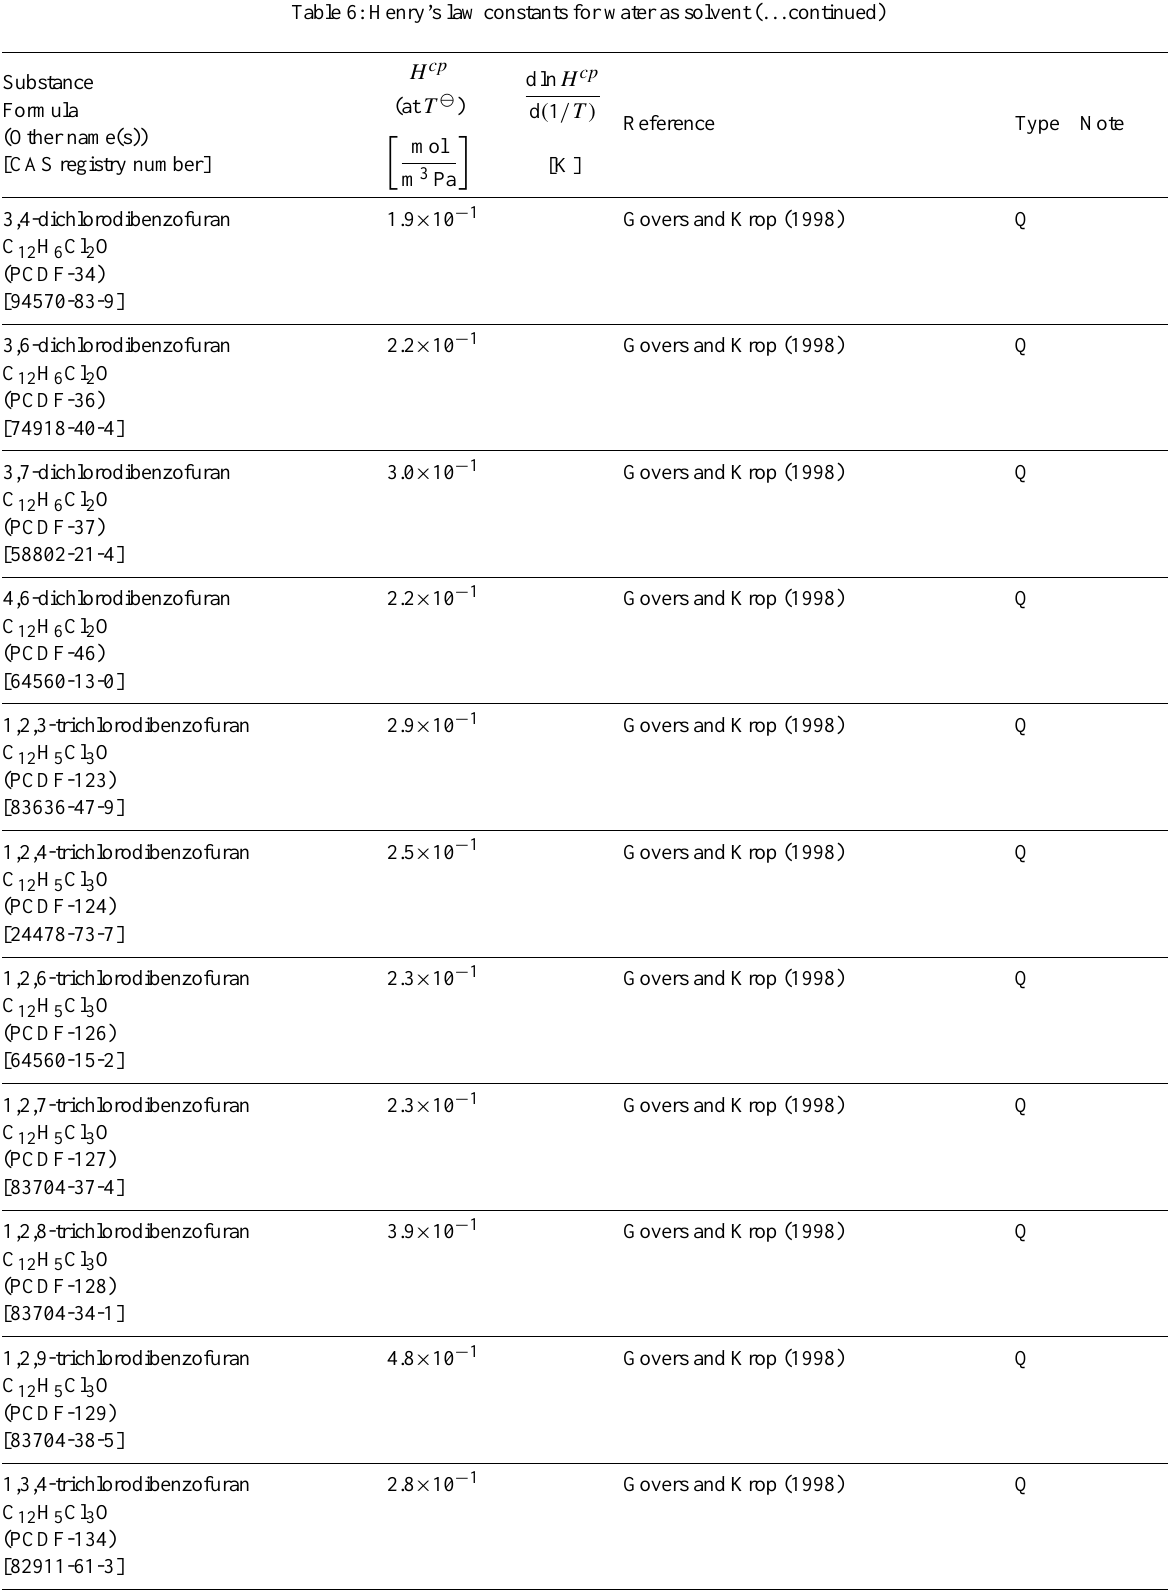
Table 6: Henry’s law constants for water as solvent